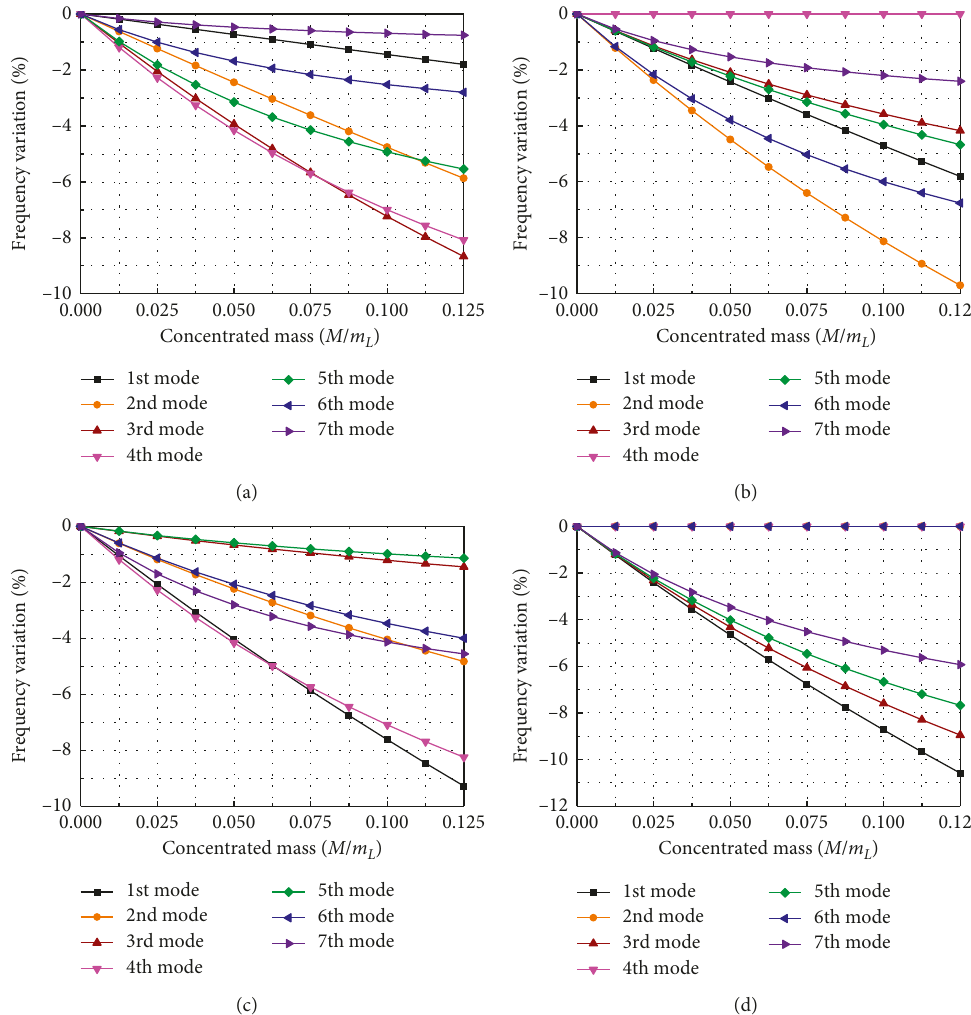
Figure 4: Frequency variations of the simplified model with 1 additional concentrated mass: (a) 1 concentrated mass on position 1; (b) 1 concentrated mass on position 2; (c) 1 concentrated mass on position 3; and (d) 1 concentrated mass on position